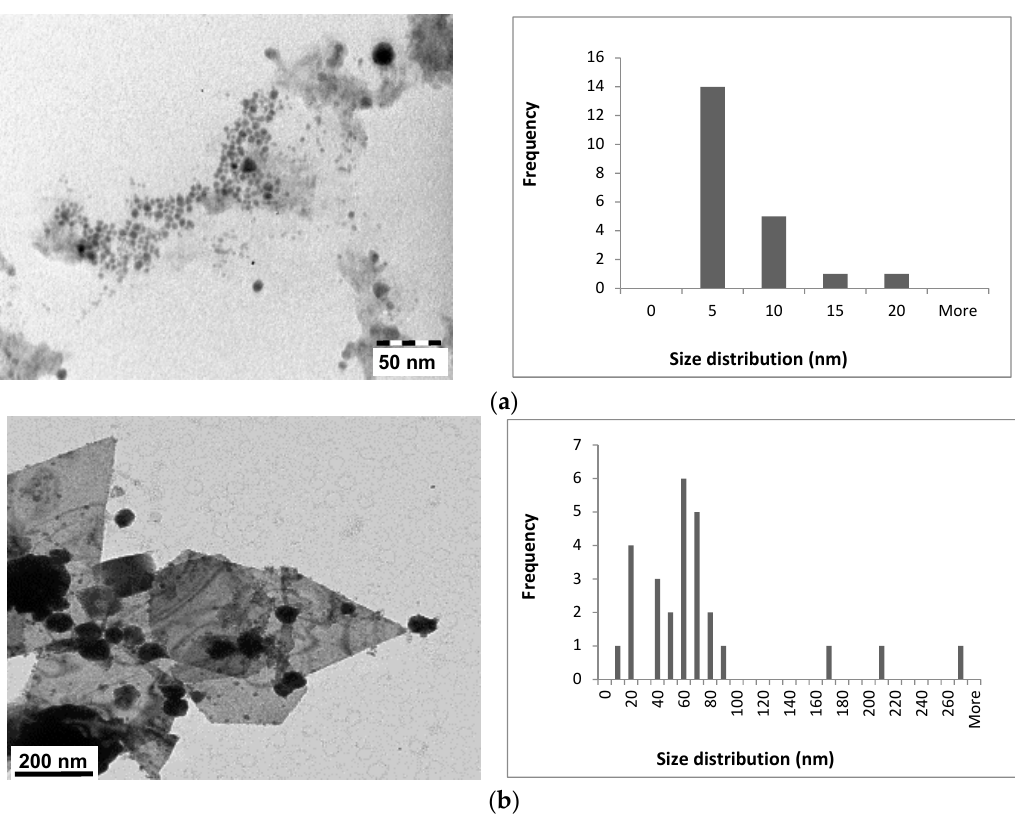
Figure 7. TEM images and NP size distributions obtained for ( a ) AC-AgNPs; ( b ) AR-AgNPs and ( c ) Fv-AgNPs. AC: Aqueous extract subjected to organic solvent partitioning. AR: simple aqueous extraction.